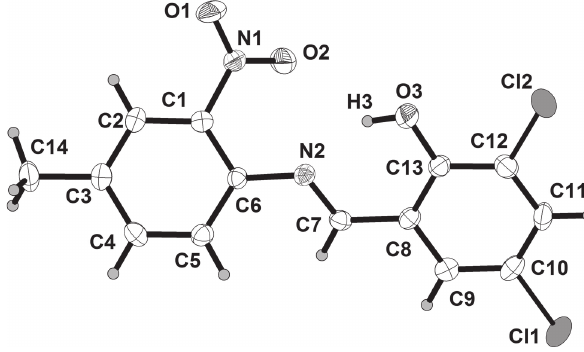
Table 1: Data collection and handling.